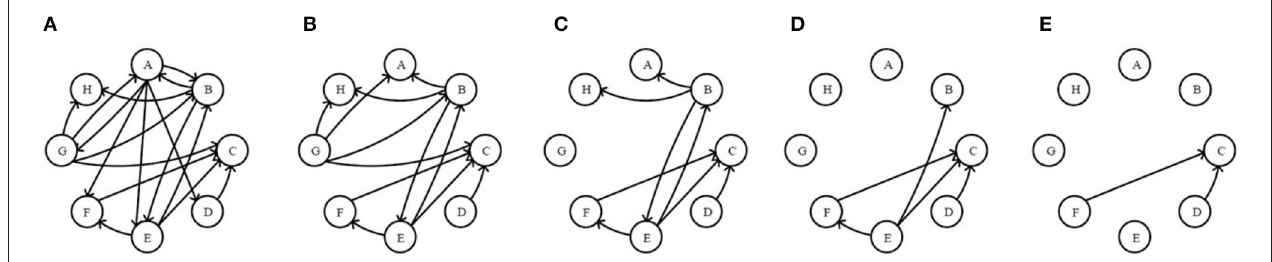
FIGURE 3 | The original network and the first four residual networks based on sending-edge removal. (A) The original network. (B) The 1 stRN . (C) The 2 ndRN . (D) The 3 rdRN . (E) The 4 thRN .